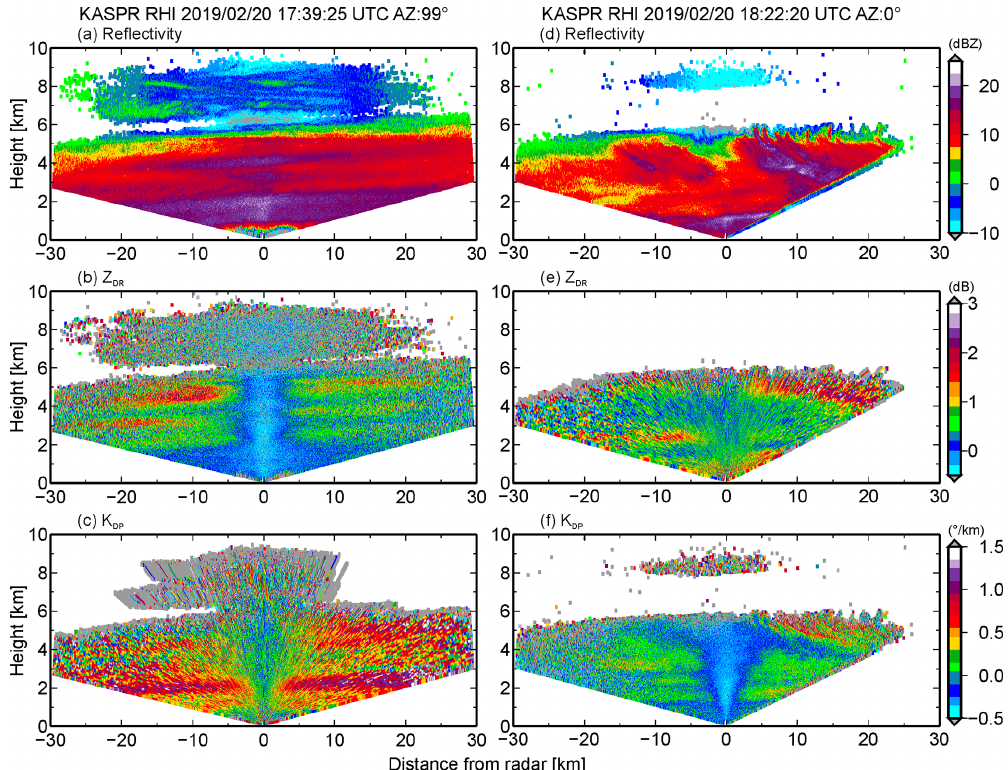
Figure 6. KASPR (a, d) reflectivity, (b, e) Z DR , and (c, f) K DP from RHI measurements (a, b, c) at 17:39UTC at an azimuth angle of 99 ◦ and (d, e, f) at 18:22UTC at an azimuth angle of 0 ◦